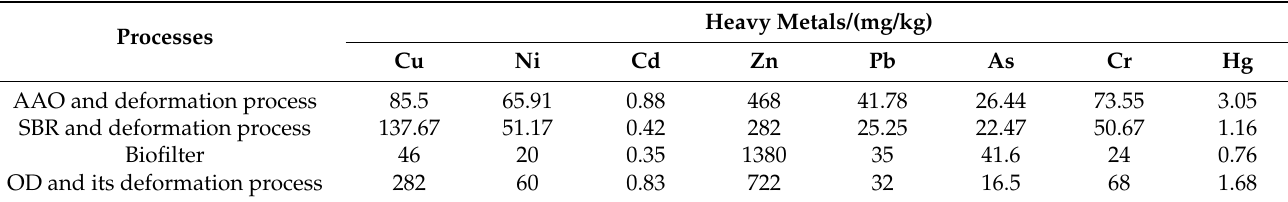
Table 5. Variation in sludge composition for different treatment processes.